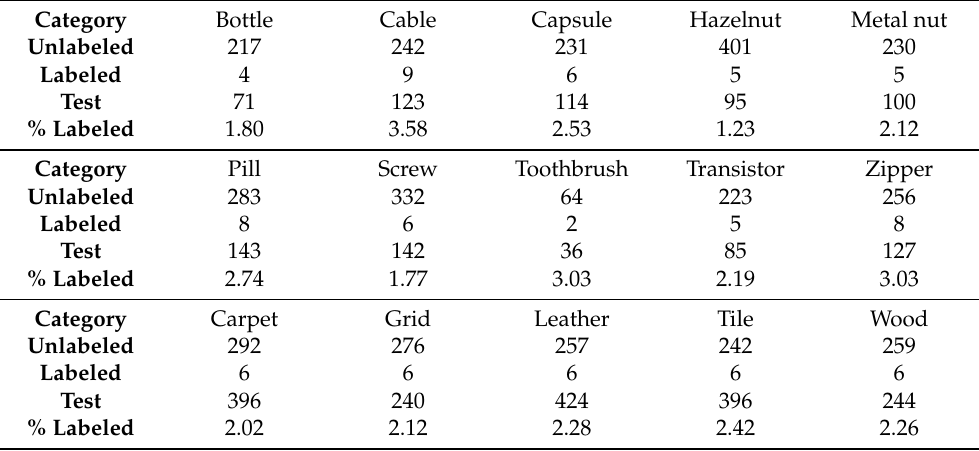
Table 1. Number of unlabeled, labeled, and test samples in the dataset for each category of the MVTec-AD